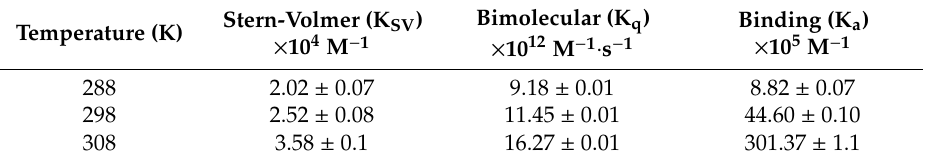
Figure 2. Left ordinate Stern–Volmer plots at three temperatures, 288 K, 298 K and 308 K, and right ordinate time-resolved fluorescence lifetime plot at 298 K; (NBD) = 4 μ M, (piperine) = 0–20 μ M. R 2 > 0.98. Table 1. Stern-Volmer constant (K SV ), bimolecular constants (k q ) and binding constant (K a ) for the complex NBD and piperine at 288, 298 and 308 K.